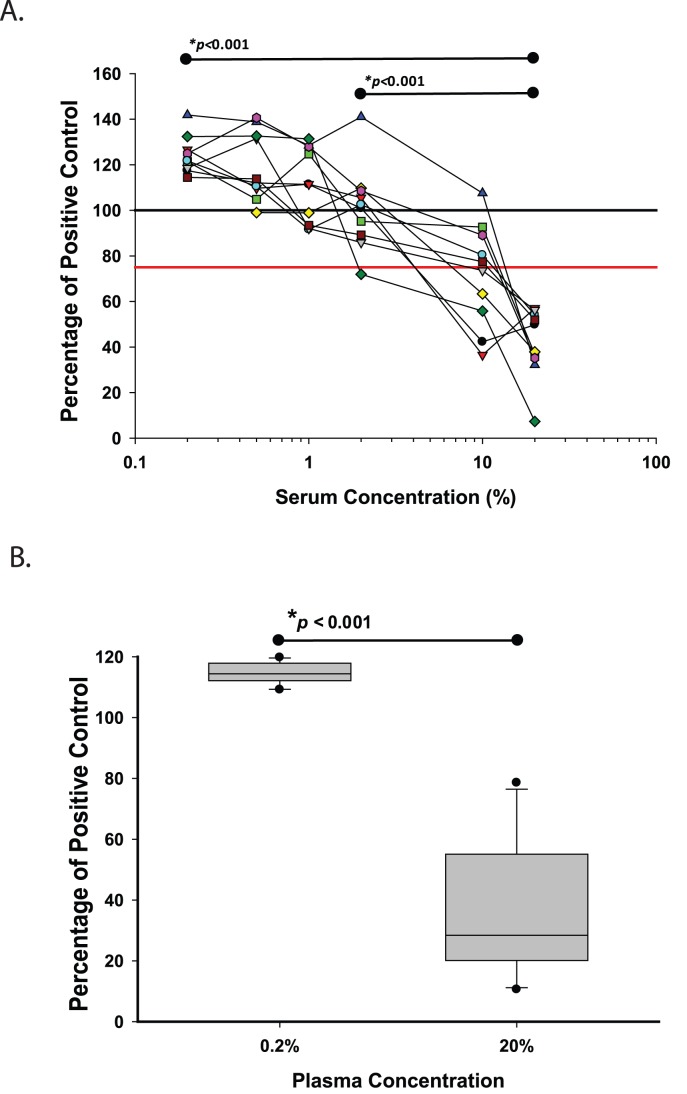
LPS masking in macaque plasma.Exogenous LPS was added to samples at a fixed concentration of LPS (50 pg/mL) from a reference E. coli standard after dilution in 10 mM MgCl2, as indicated. LAL testing with diazo-coupling was performed on all samples and each result was compared to an LPS standard at the same concentration in diluent alone. A) Plasma samples from 10 uninfected and SIV-infectemacaques were diluted from 20% (1∶5 dilution) to 0.2% (1∶500 dilution). Levels of no inhibition (black line) and 25% inhibition (red line) are indicated. B) Plasma samples from 10 SIV-infected macaques were diluted and measured in 20% and 0.2% concentration. Shown are mean ± SD for each animal. *Mean percent inhibition was compared between the indicated concentrations using the paired t-test.